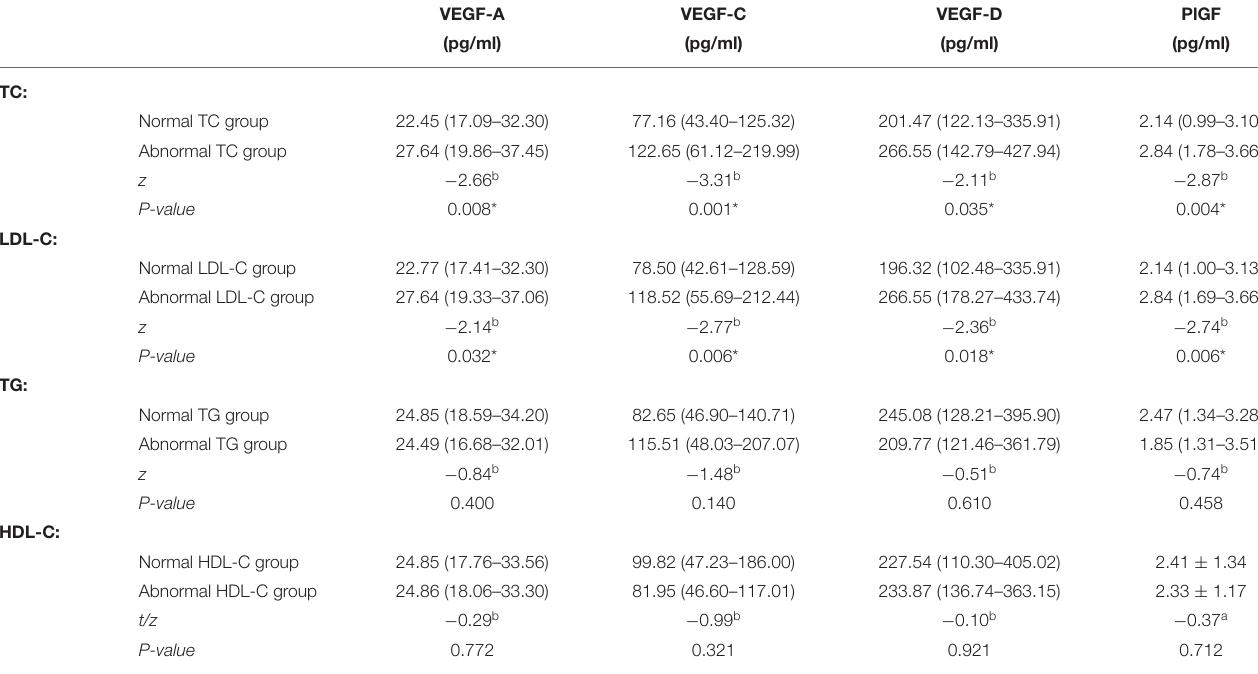
TABLE 3 | Comparison of the circulating level of VEGF-A, VEGF-C, VEGF-D, and PlGF in all patients with abnormal and normal TC, LDL, TG, and HDL. VEGF-A VEGF-C